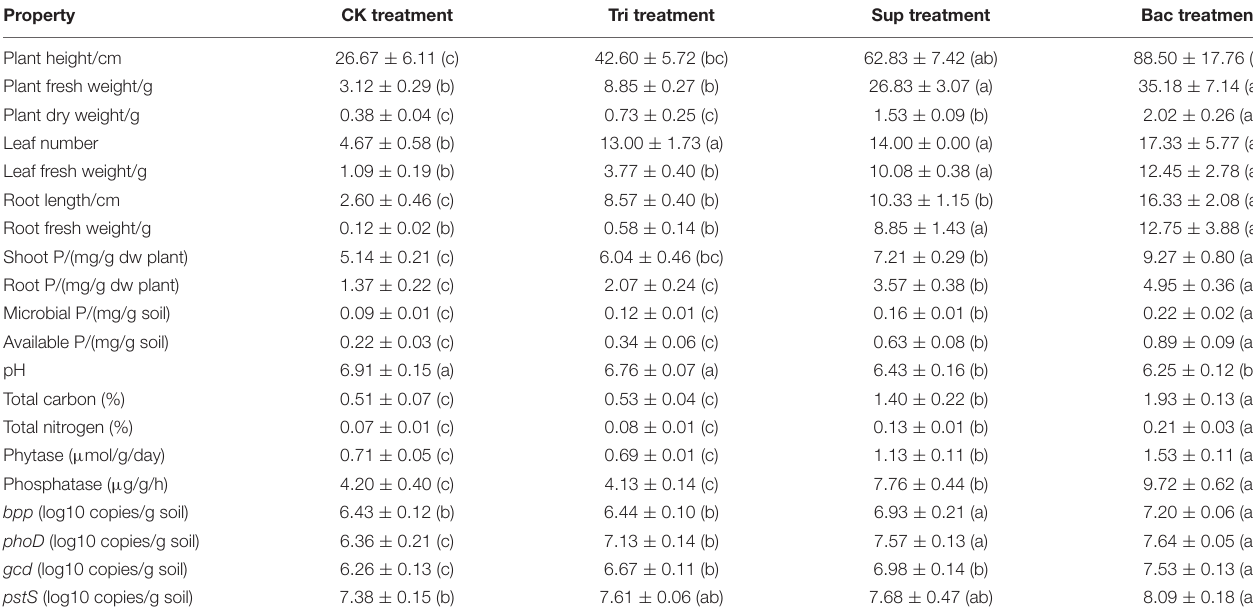
FIGURE 1 | The colony-forming unit number of phosphate-solubilizing bacteria (A) and content of indole acetic acid (B) during 40 days. The results are the mean value of five replicates; error bars represent standard error. Different letters above the column indicate significance ( p < 0.05). TABLE 1 | Vegetation properties, soil physicochemical properties, enzyme activity, and P-cycling-related gene abundance in four potted treatments. Property CK treatment Tri treatment Sup treatment Bac